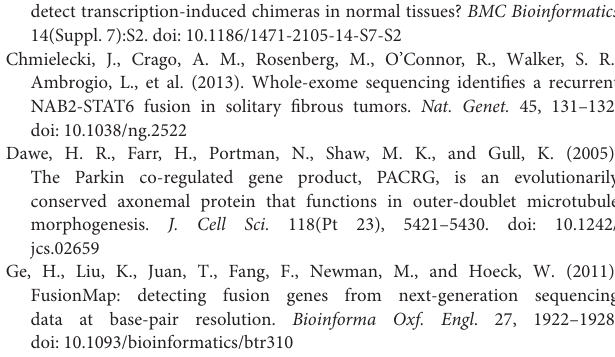
Table S1 | The score weights of single and combined features in confFuse scoring algorithm. Table S2 | The verified fusion genes in the first training data. Table S3 | The verified fusion genes in the second training data. Table S4 | The recovery of verified fusions in deFuse, confFuse-6.5, and confFuse-8. Table S5 | The recovery of verified fusions in fusionMap. Table S6 | The recovery of verified fusions in soapFuse. Table S7 | The experimental validations in three breast tumor samples. Table S8 | The high-confidence fusions in prostate cancer samples. Table S9 | The correlation of verified fusions and supporting reads in fusionMap. Table S10 | The correlation of verified fusions and supporting reads in